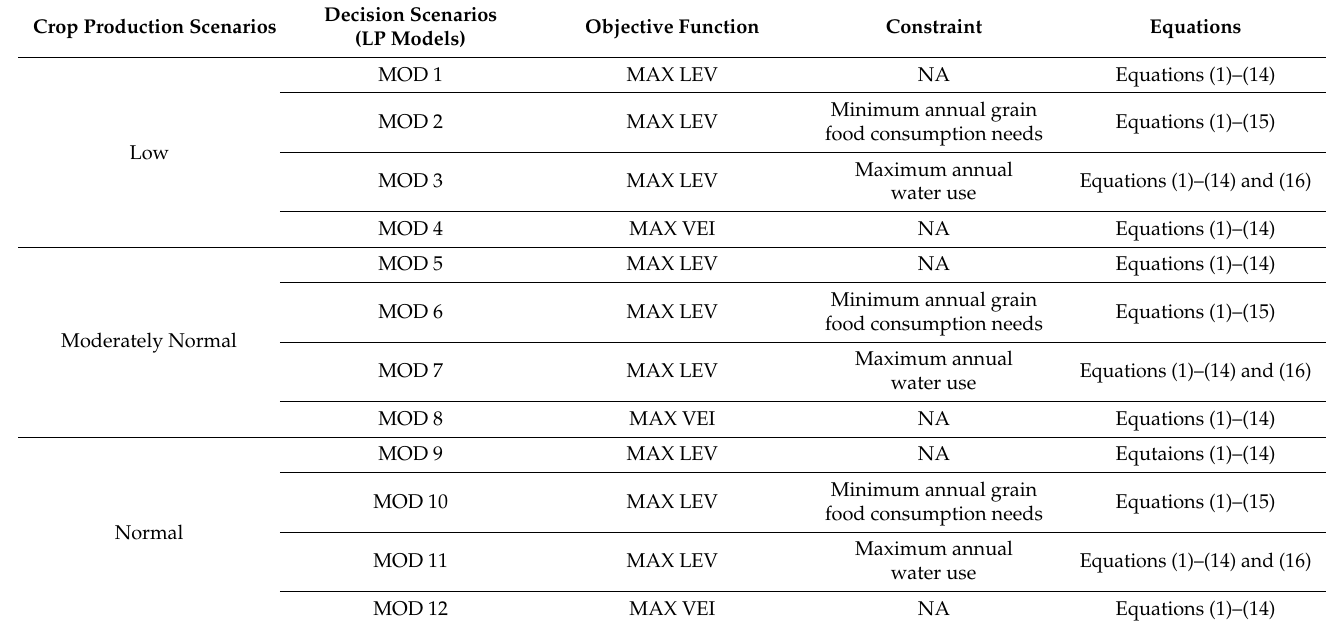
Table 1. Summary of crop production and decision scenarios and corresponding linear programming (LP)